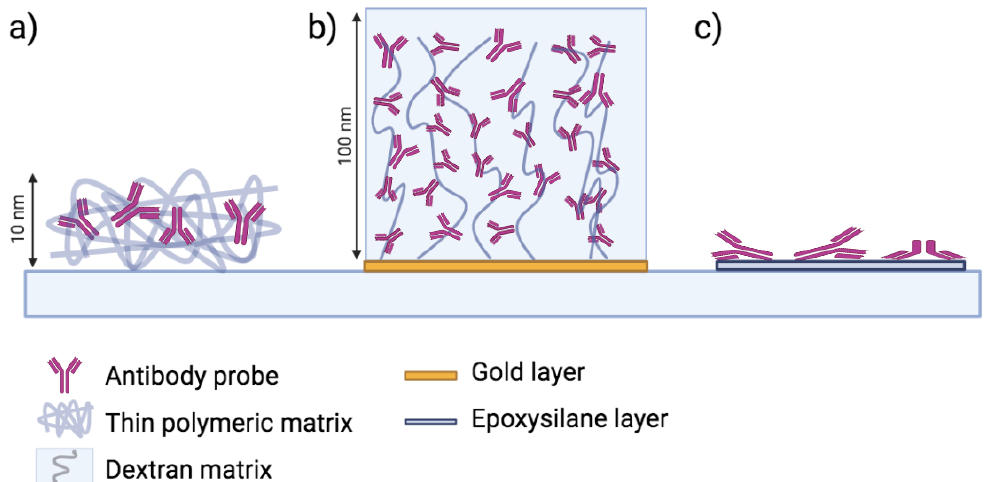
Figure 3. A graphical scheme of immobilized antibody probes on: ( a ) 10 nm thick polymeric coating (MCP-2); ( b ) 100 nm thick CM-dextran matrix; ( c ) epoxysilane